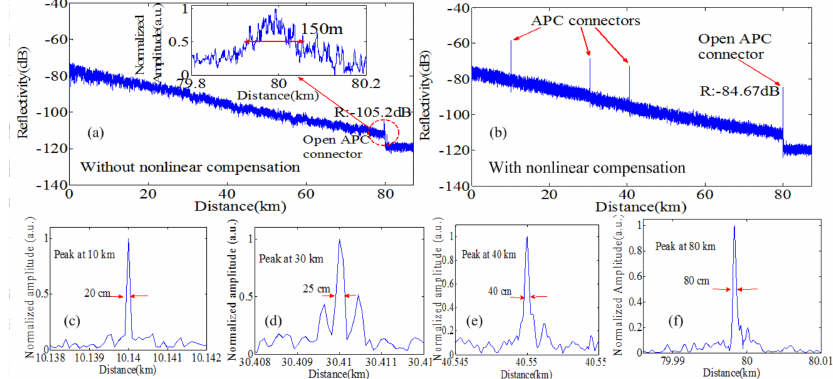
Figure 11. Measured Rayleigh backscattering and Fresnel reflections traces for an 80 km FUT with APC-APC connections and open APC connector without ( a ) and with ( b ) the nonlinear phase compensations. ( c – f )’s y axis are transformed a logarithm to a normalized linear coordinate (reprinted from Ding et al. [34] with permission of SPIE; copyright